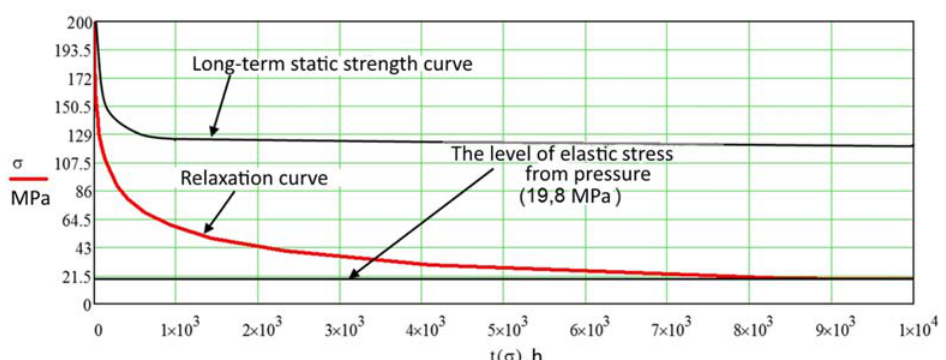
Figure 6: Relaxation and long-term strength curves for 08Cr16N11M3 steel for the initial stress of 200 MPa and the temperature of 600